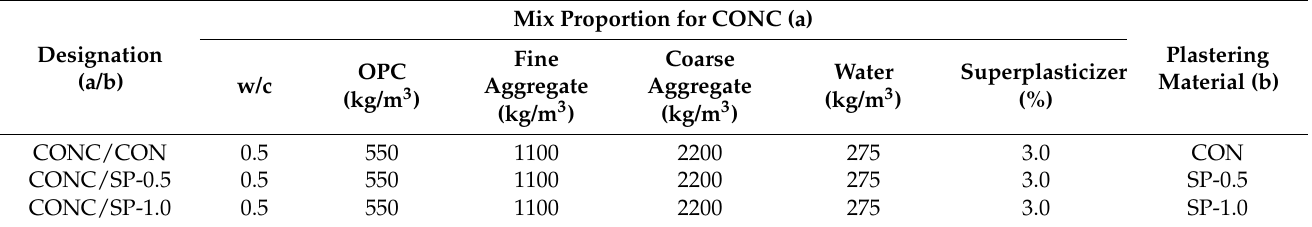
Table 3. Mixture proportions for plastered